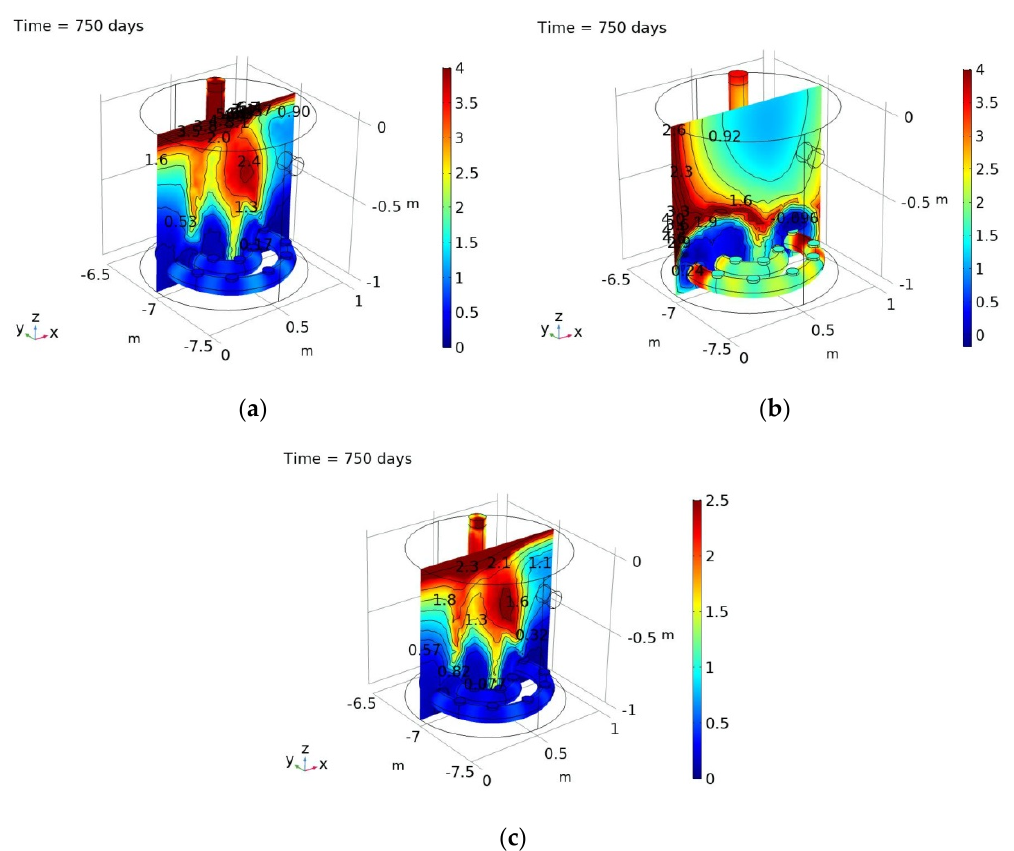
Figure 5. Distribution pattern in filter bags filled with ( a ) Polonite, ( b ) Top16 and ( c ) Filtralite P sand and fitted with a spiral slotted distribution pipe. Color indicates the P concentration (mg L − 1 ) in the material after filtration of wastewater containing 12 mg P L − 1 over 7 months.